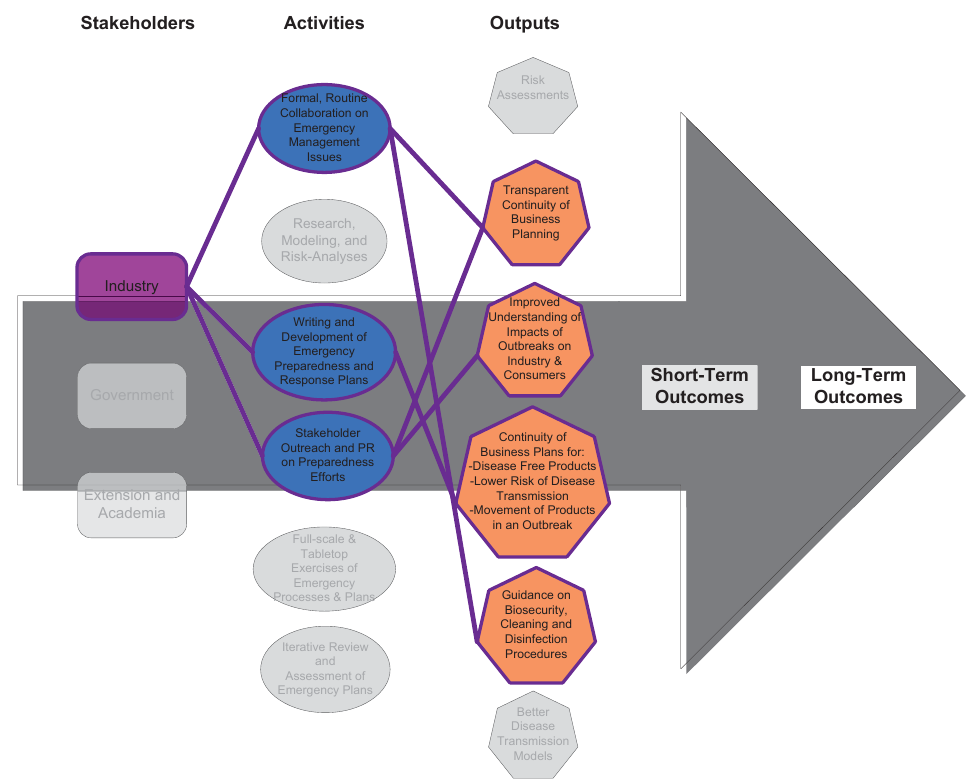
Figure 1. Industry’s lead responsibilities in continuity of business.